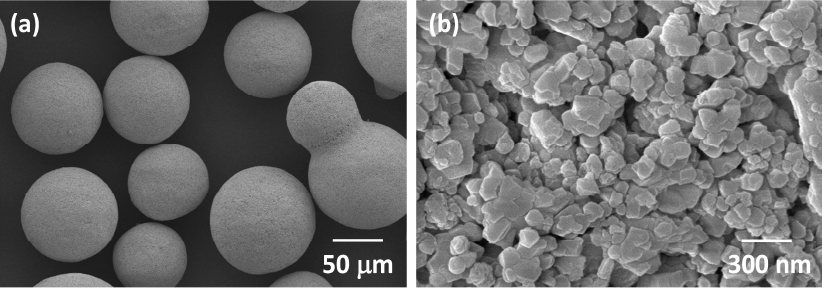
Figure 1. SEM micrographs of ( a ) secondary and ( b ) primary particles of as-received Tosoh Zpex Smile powder.